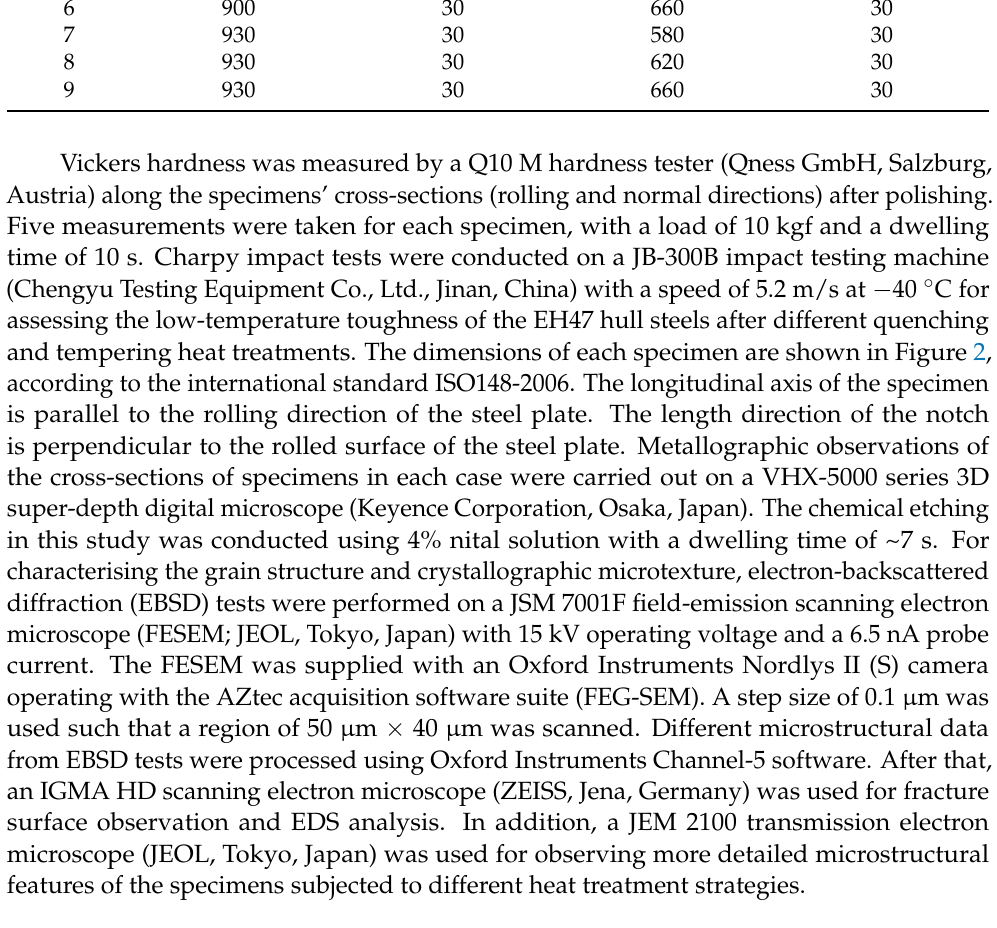
Figure 3. The microstructure of the as-received high-strength EH47 hull steel. The metallographic microstructure subjected to various quenching and tempering temperatures is shown in Figure 4. In most cases, the microstructure consists of acicu- lar/polygonal ferrite, lath-tempered martensite, and some retained austenite. It can be clearly seen that the microstructure under lower tempering temperatures (Figure 4a,d,g for 580 °C and Figure 4b,e,h for 620 °C) presents higher volume fractions of tempered martensite, which is hereditary from the quenching process. The specimens subjected to the highest tempering temperature (660 °C) have a higher content of ferrite, as shown in Figure 4c,f,i. This is because the recrystallisation phenomenon occurs in the tempered martensite at a relatively high tempering temperature, which unsurprisingly leads to in- creased ferrite. Moreover, it can be seen that even higher quenching or tempering temperatures lead to coarsened grain size, and the specimens tempered at lower temperatures (Figure 4a,d,g for 580 °C and Figure 4b,e,h for 620 °C) present obvious heterogeneity of the phase distribution. With the tempering temperature increasing to 620 °C, more carbides are obviously precipitated, as shown in Figure 4c,f,i. The growth of carbides was supposed to occur via Ostwald ripening during the tempering process [10]. In addition, the coarsen-